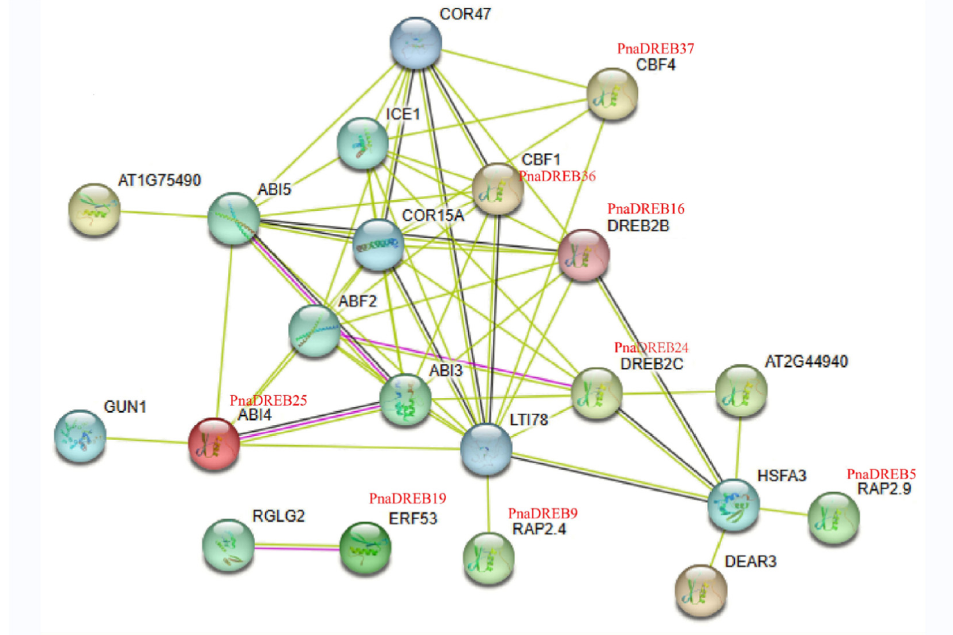
Figure 6. Interaction network for PnaDREB s based on their close homologs in A. thaliana . The nodes with different colors represent different proteins and the lines with different color represent different types of evidence for the interaction. Light blue lines show known interactions from curated databases, rose red lines show known interactions experimentally determined, blue lines show predicted interactions of gene co-occurrence, black lines show interactions of co-expression, and yellow lines show interactions of text